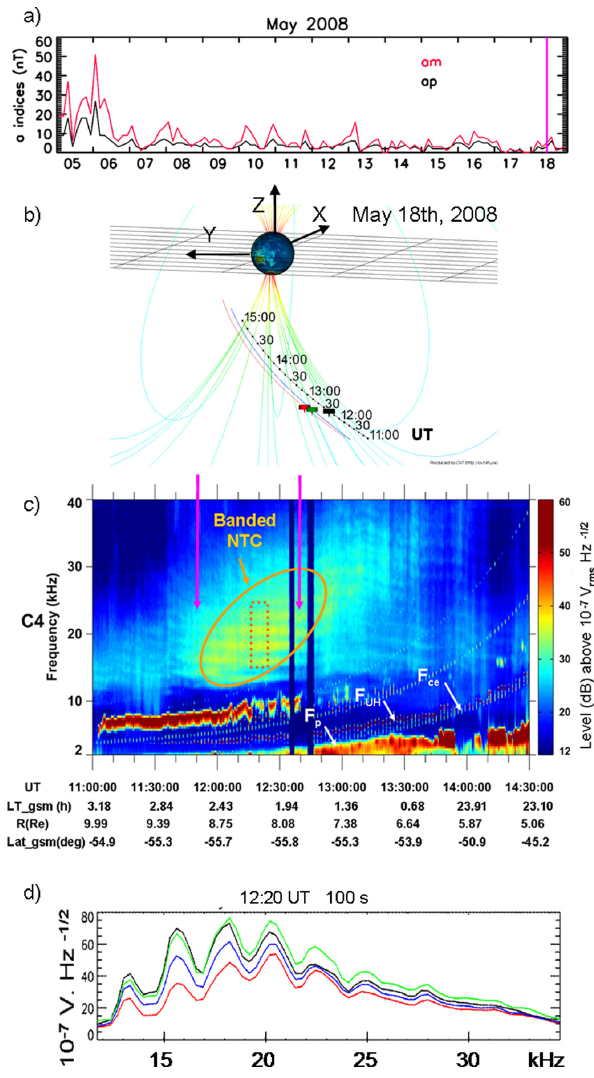
Fig. 6. NTC emissions observed on 18 May 2008 from Clus- ter constellation. (a) 3h planetary indices in a two week inter- val prior and during the event (starting at purple vertical line). (b) Cluster constellation on its inbound pass, in GSM coordinate system at 12:20UTC. Cylinder-like symbols indicate satellite po- sitions, respectively in black for C1, red for C2, and green for the tilted pair C3–C4. (c) Spectrogram from WHISPER instrument on board C4. Vertical arrows point to the time interval of promi- nent NTC emissions. Sounder resonances and natural wave signa- tures measure local characteristic frequencies, gyro-frequency F ce , plasma frequency F p , and upper hybrid frequency, F UH , pointed by white arrows. Intense emissions at ∼ 6–8kHz, observed from about 11:00 to 12:40UTC, are spurious oscillations under investigation. (d) Electric field frequency spectra measured on the four satellites at 12:20UTC, averaged over a 100s time interval. Intensity varia- tions are shown in black for C1, red for C2, green for C3 and blue for